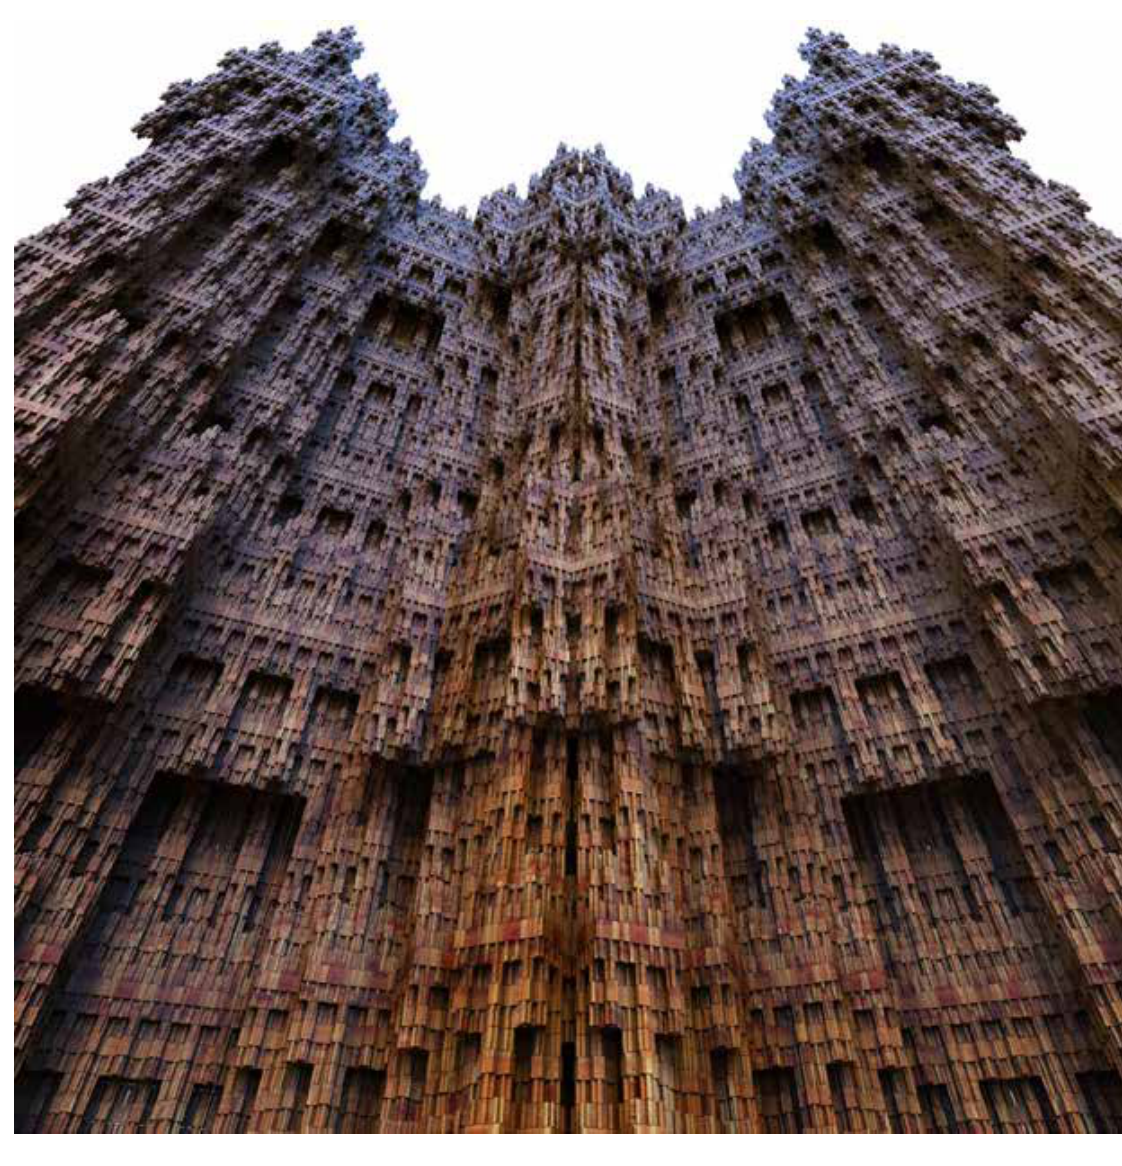
Figure 22: 5 minute architecture (2016). Digital